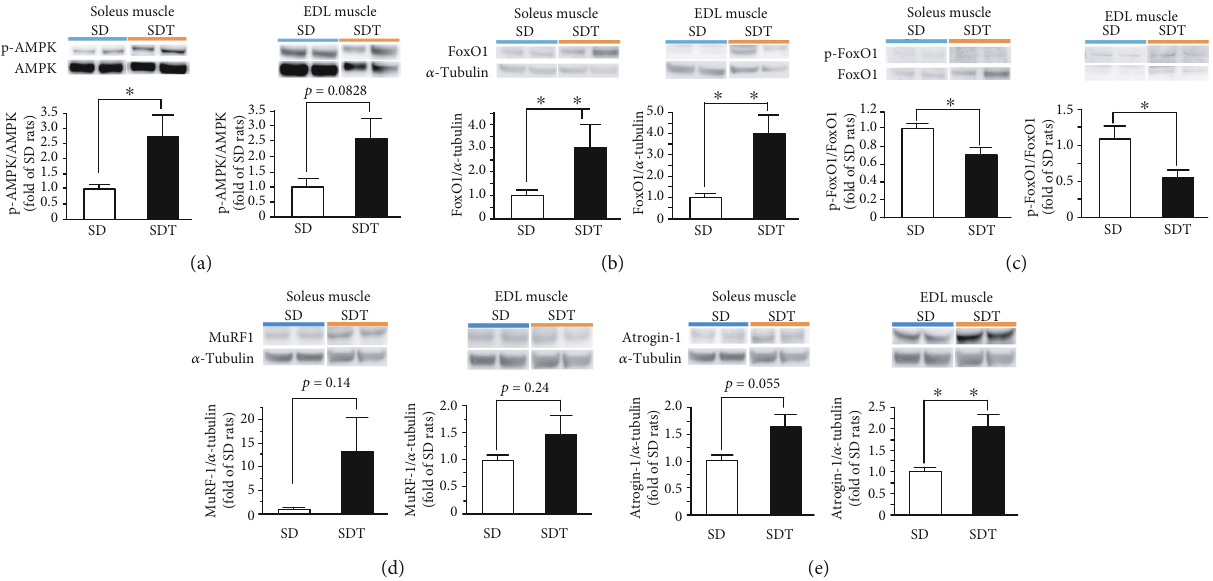
Figure 5: Muscle protein degradation in SD and SDT fatty rats, as determined by western blot analysis. Phosphorylated AMPK in the soleus and EDL muscles (a). Protein expression of FoxO1 in the soleus and EDL muscles (b). Phosphorylated FoxO1 in the soleus and EDL muscles (c). Protein expression of the E3 ubiquitin ligases MuRF-1 (d) and Atrogin-1 (e) in SD and SDT fatty rats, as determined by western blot analysis. ∗ p < 0 : 05 and ∗∗ p < 0 : 01 vs. SD